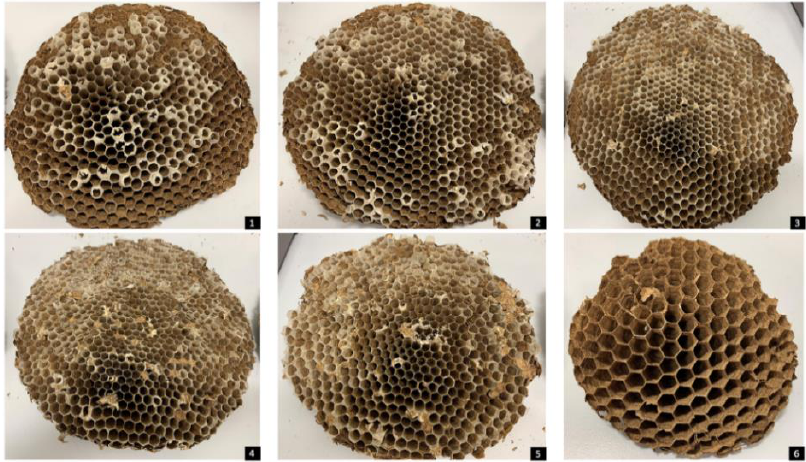
Figure 12. Combs from the first nest organized in order of formation: 1: first, 2: second, 3: third, 4: fourth, 5: fifth and 6: the last comb formed. (From upper to bottom).